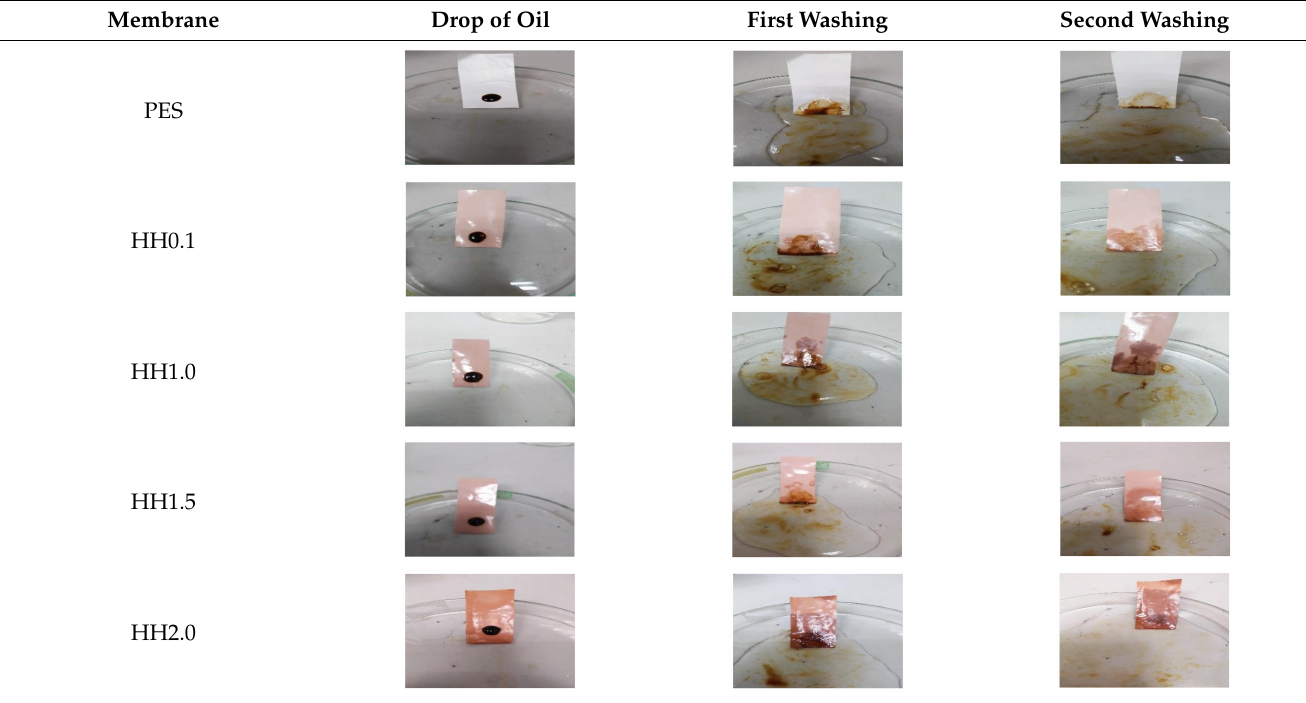
Table 4. Procedure to study the antifouling resistance of dry membranes against oil droplets.